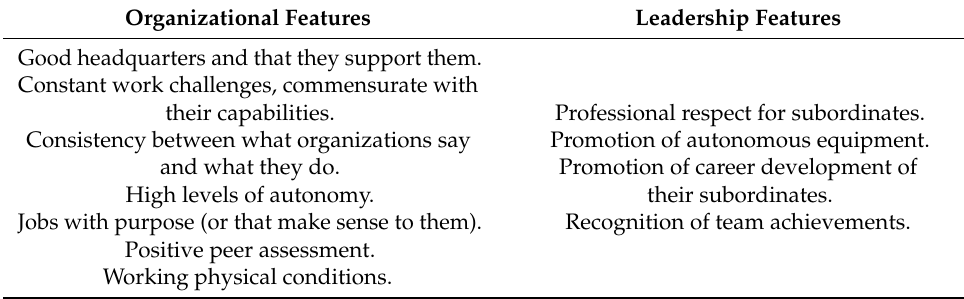
Table 10. Attributes and good practices mentioned by high-performing managers. Organizational Features Leadership